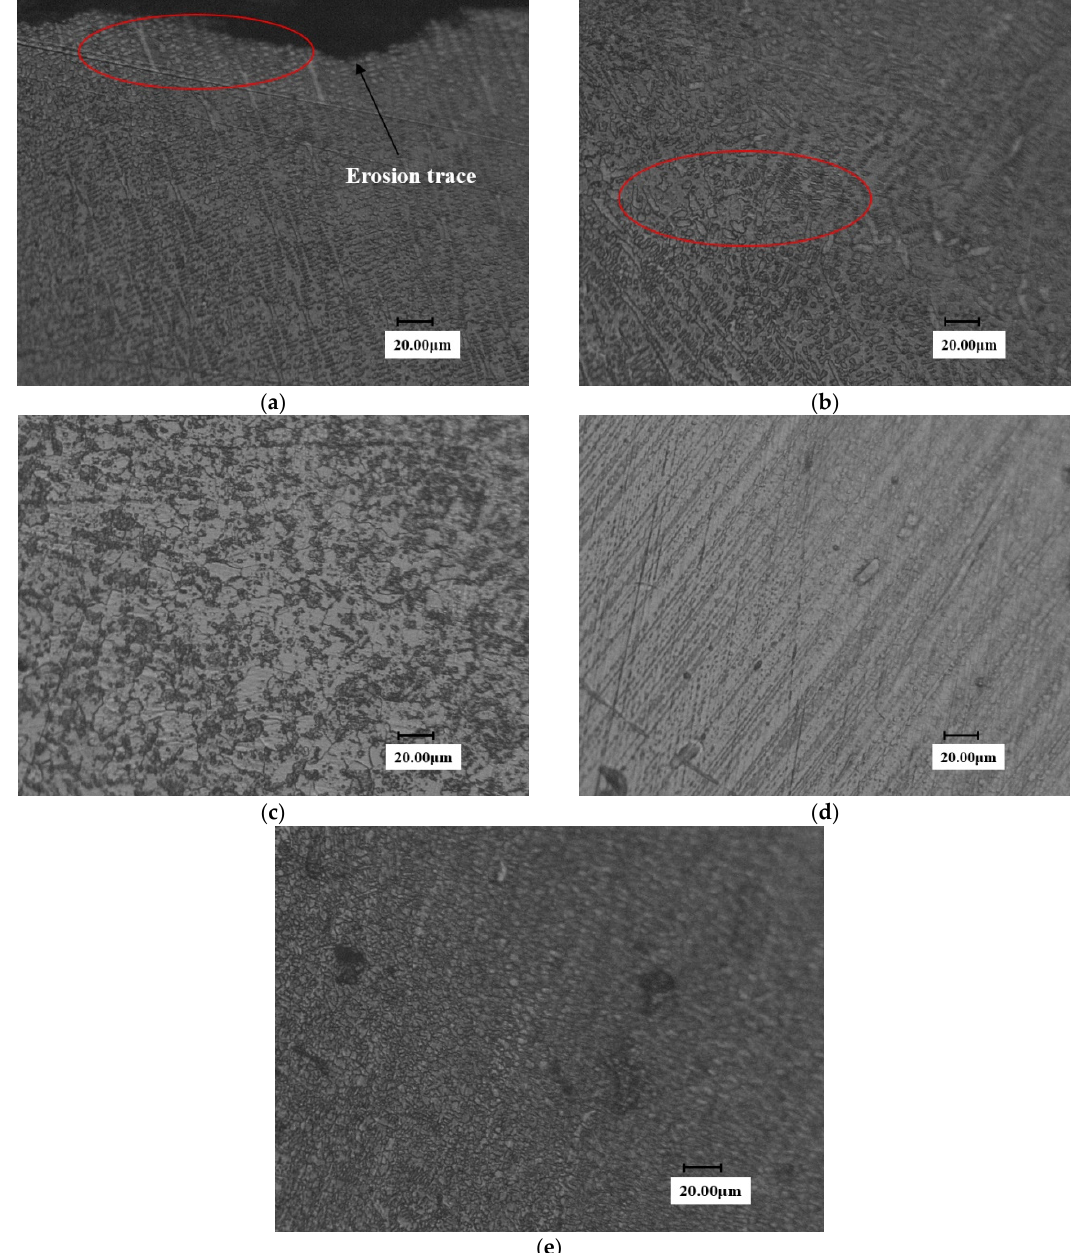
Figure 13. Metallographic diagram of cladding sample surface. ( a ) End face of laser Cladding sample ( b ) Transition zone of laser Cladding sample ( c ) Substrate section of laser Cladding sample ( d ) No erosion zone on the surface ( e ) erosion zone on the surface.